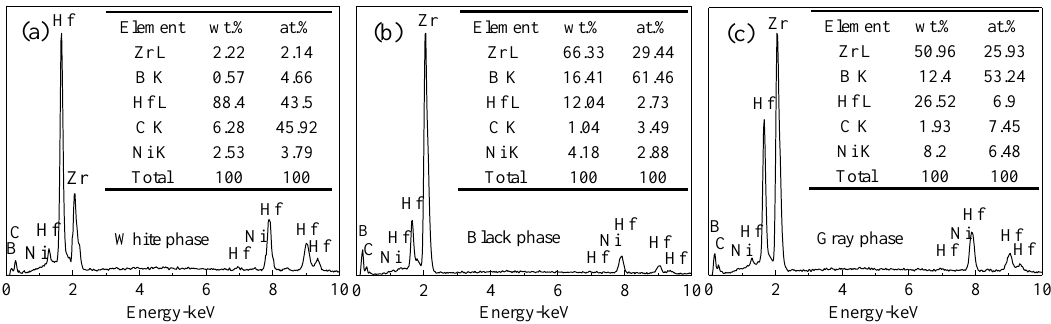
Figure 2 . Scanning electron microscope in back scattered electron mode (SEM–BSE) micrographs of polished surfaces of ZrB 2 –HfC ceramics with different HfC content: ( a ) ZrB 2 –10 wt % HfC (ZH10N), ( b ) ZrB 2 –20 wt % HfC (ZH20N), and ( c ) ZrB 2 –30 wt % HfC (ZH30N).